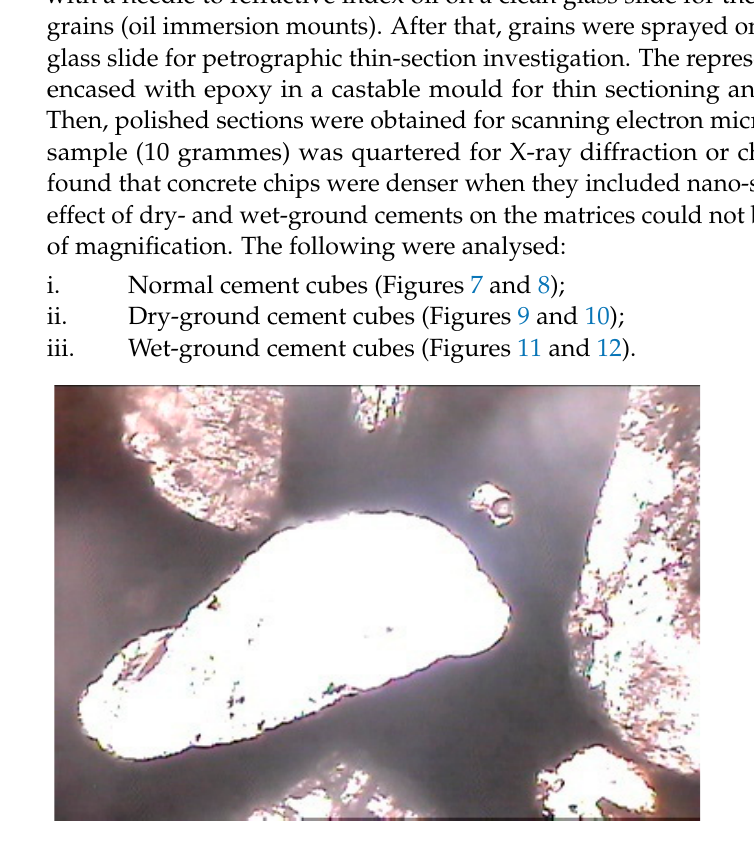
Figure 7. Photomicrograph of normal cement–fine-aggregate mix showing micropores within cement and loose contact between cement paste and aggregate grains (magnification of 60× under non-polarized light).